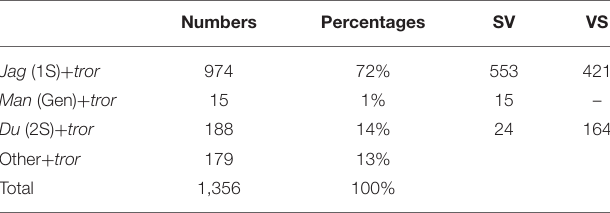
TABLE 2 | Co-distribution of egophoric pronouns and tror